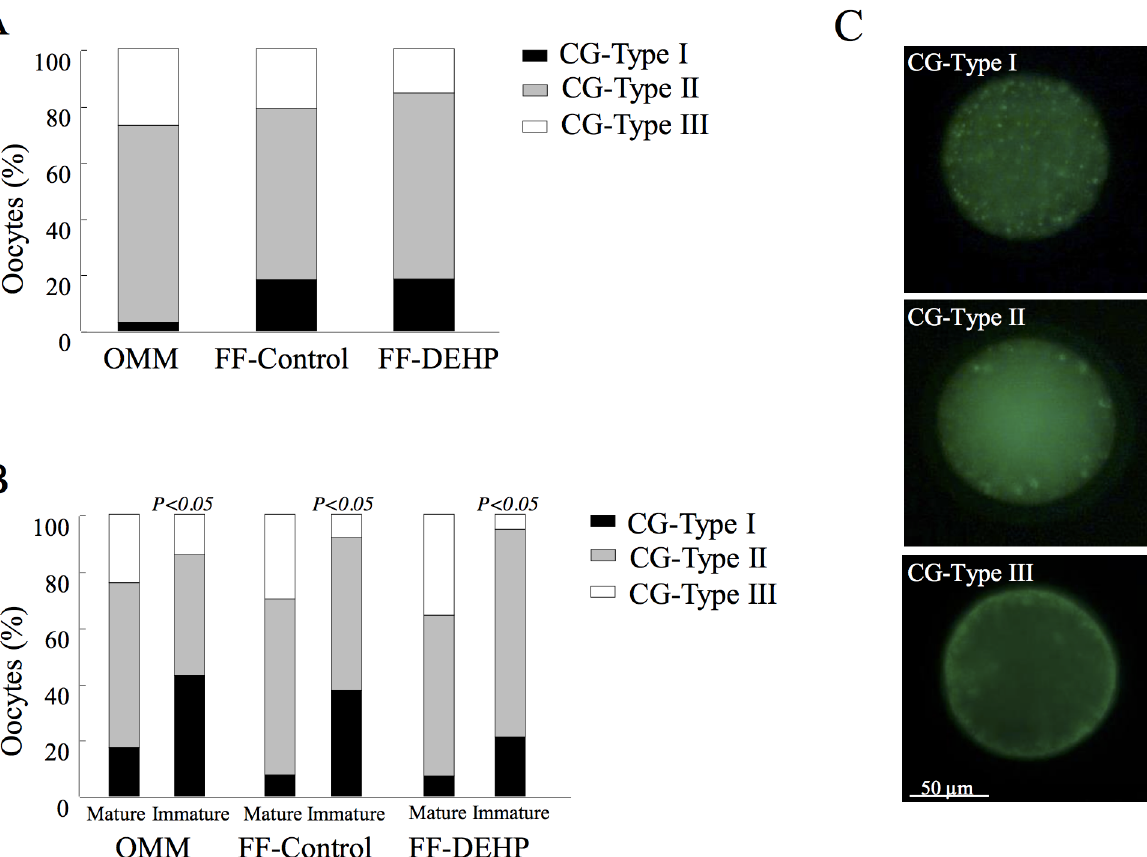
Fig 8. Cortical granule (CG) distribution in oocytes matured in follicular fluid (FF) aspirated from control (FF-control) and DEHP-treated (FF-DEHP) cows, or in oocyte maturation medium (OMM). At the end of maturation, oocytes were denuded, fixed and stained with FITC – PNA to evaluate the pattern of CG distribution and counterstained with DAPI. (A) Proportion of oocytes in each CG-distribution type, calculated out of total oocytes for each experimental group. (B) Distribution of CG types within mature and immature oocytes for each experimental group. P -values indicate different CG-distribution patterns within meiotic stages for each experimental group. (C) Representative images of CG-distribution patterns in oocytes: CG type I, characterized by CG aggregates, representing cytoplasmically immature oocytes; CG type II, characterized by CGs localized mainly in the cortical cytoplasm and distributed as individual particles as well as small aggregates, representing partially cytoplasmically mature oocytes; CG type III, characterized by CGs more or less evenly dispersed in the cortical cytoplasm lining the oolemma, representing fully cytoplasmically mature